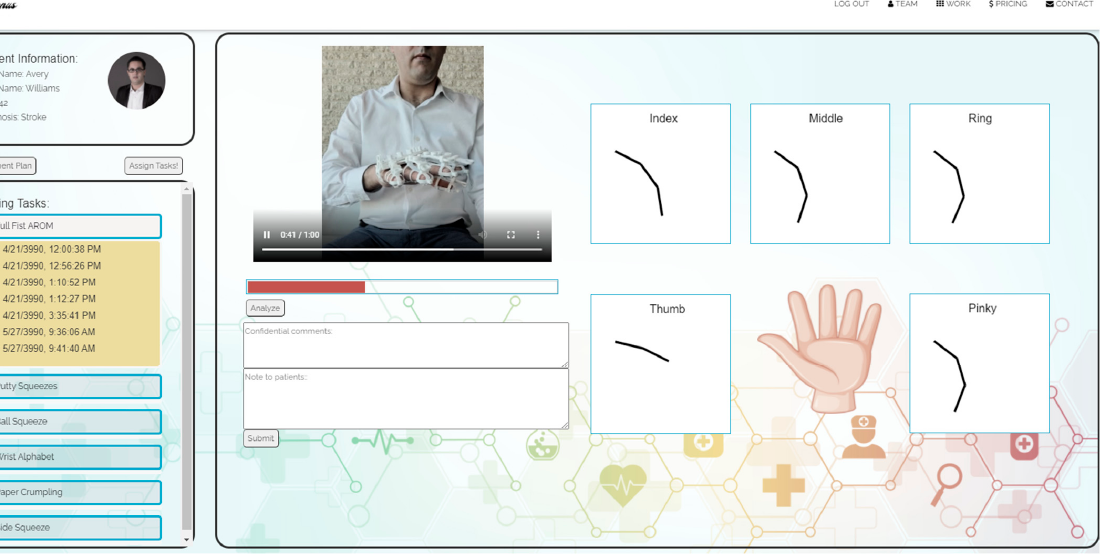
Figure 3. Screenshot of the desktop app at the clinician site. A clinician may add/remove patients, record a new exercise and assign it to the patient, and score the performance of the patient using the audiovisual data and sensory feedback (KPIs) received from the patient site.